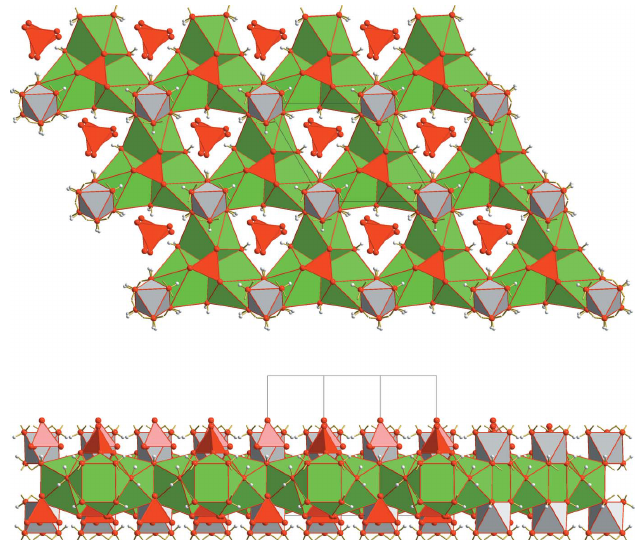
Figure 5 Polyhedral model showing the aufbau principle of the layers (top view above, side view below) as result of the interconnection of the SBUs. Polyhedra colors according to Fig. 1 to 3. Isolated selenate ions (Se2) in the three-sided pores belong to adjacent layers. The corresponding hydrogen bonds are omitted for